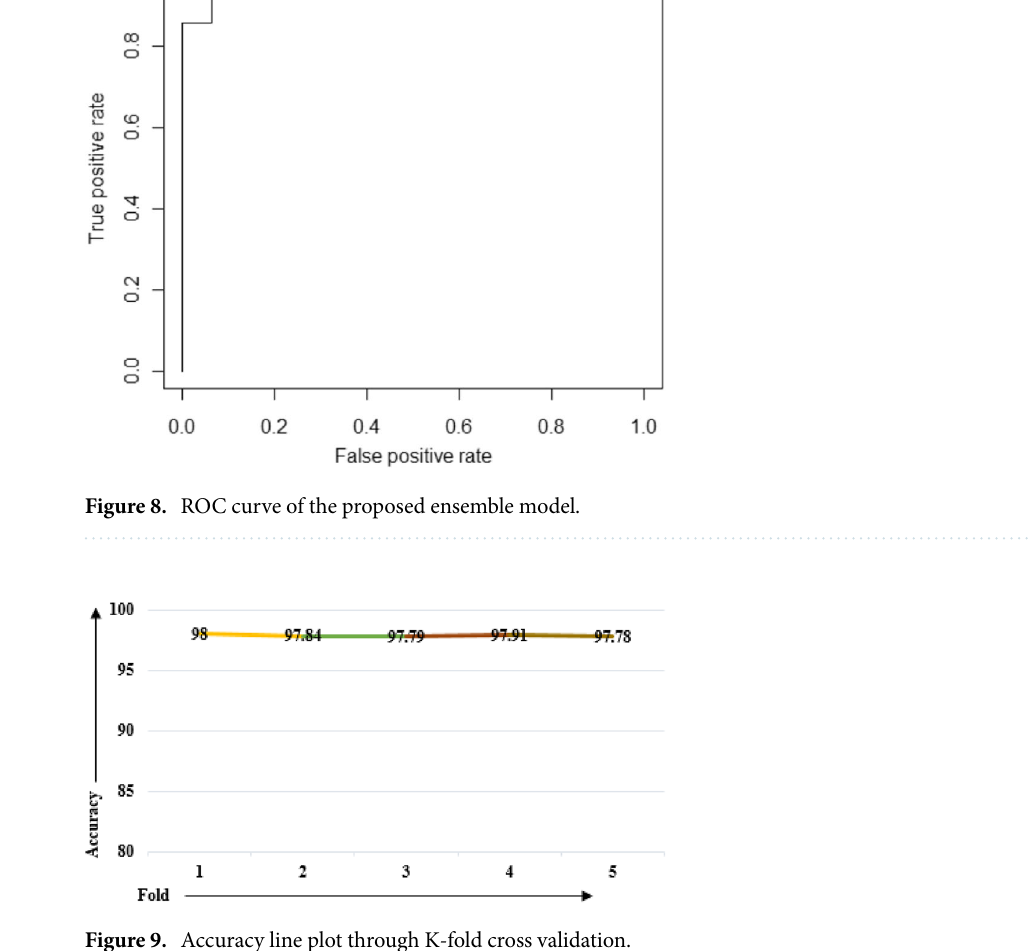
Figure 9. Accuracy line plot through K-fold cross